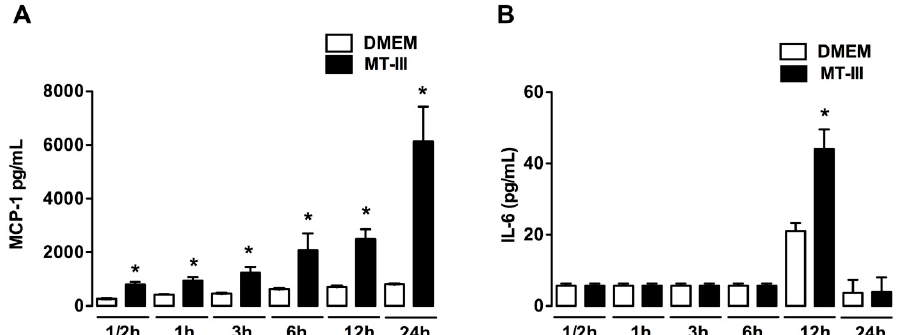
Figure 6. MT-III induces MCP-1 and IL-6 production by 3T3-L1 preadipocytes. Cells were incubated with MT-III (0.4 µ M), or DMEM (control) for 1 up to 48 h. Bar graphs show concentrations of ( A ) MCP-1 2 and ( B ) IL-6 released by cells incubated with MT-III. Cytokines concentrations were quantified in culture supernatants by Cytometric Bead Array (CBA). Results are expressed as mean ± SEM from